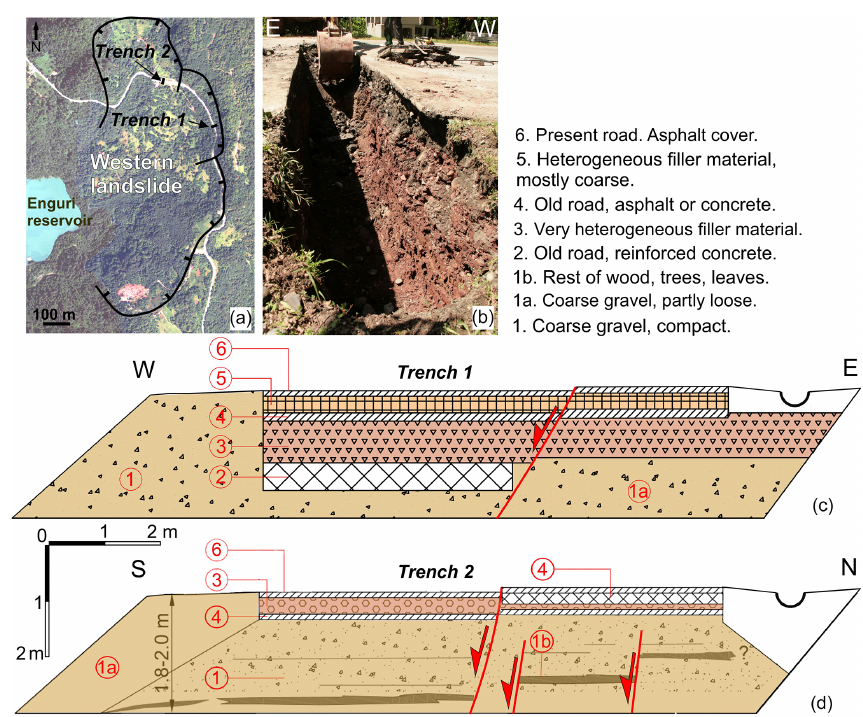
Figure 7. (a) Location of the trenches at the northern part of the unstable slope facing the Enguri reservoir. (b) Photo of Trench 2 opened across one of the main active scarps affecting the Jvari–Khaishi–Mestia road; the location is shown in (a) . Panels (c) and (d) show logs of the northern and western walls of Trench 1 and 2, respectively. Numbers refer to the legend. Present and old, offset roads are white. The oldest road is downthrown to the west by 1.3m. The red lines show the location of shallow active slip